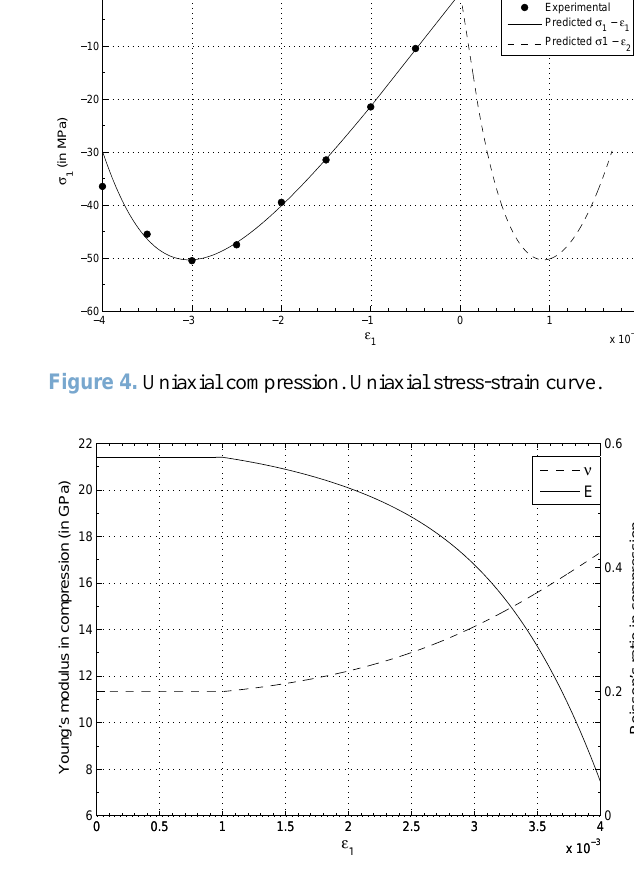
Figure 5. Uniaxial compression. Evolutions of Young’s modulus and Poisson’s